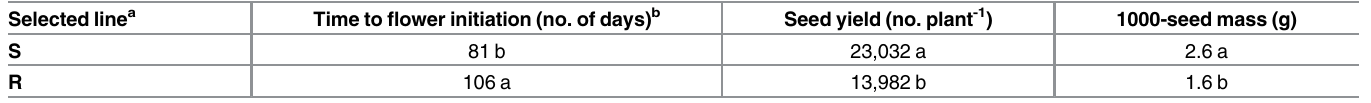
Table 3. Reproductive parameters of dicamba-fluroxypyr – susceptible (S) and – resistant (R) K . scoparia from the noncompetitive growth study averaged over experimental runs (N = 12). Selected line